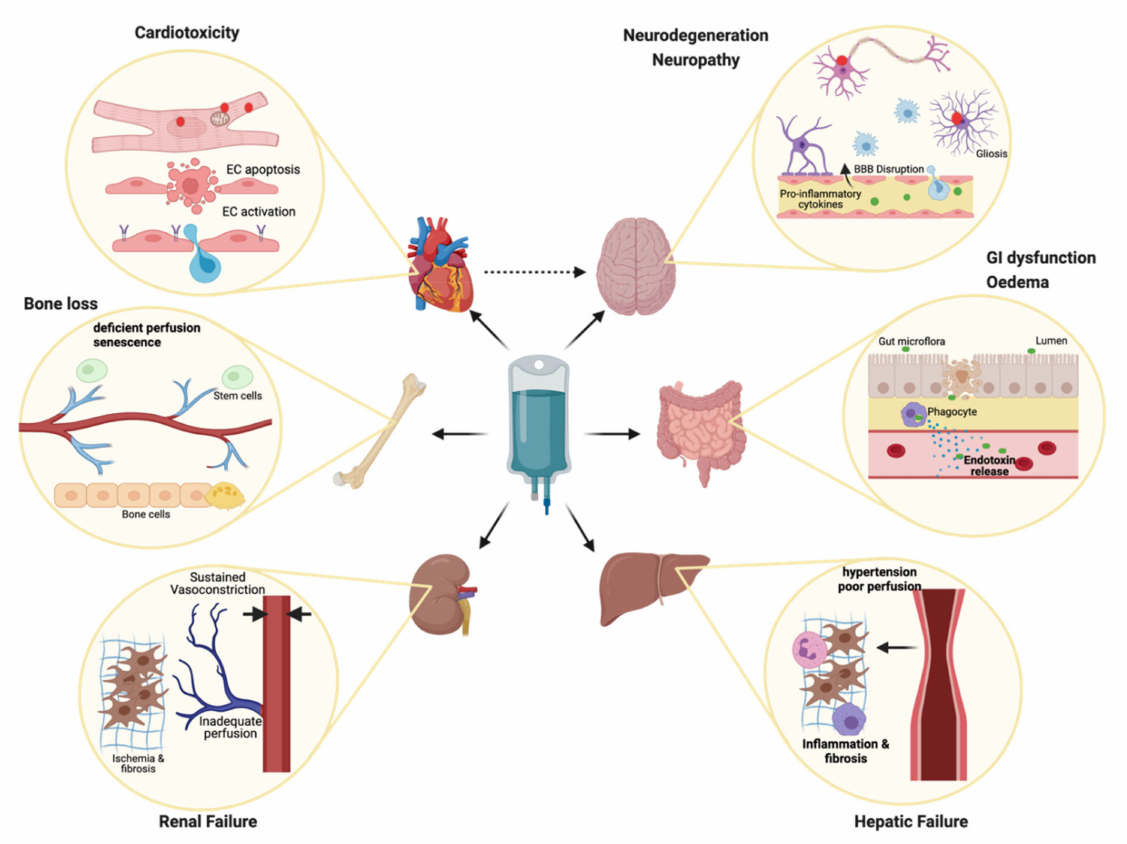
Figure 2. Tomorrow’s problem. Chemotherapy is associated with severe side effects including multi-organ failure. The best characterized side effect of therapy is cardiotoxicity, which can become apparent immediately or in the years following therapy, in severe cases leading to chronic heart failure and death. Endothelial cell apoptosis or activation can lead to increased risk of thrombotic events. Cancer patients also commonly experience chemotherapy-induced cognitive impairment, which may be the result of neurotoxicity, neuroinflammation, BBB breakdown, oxidative stress, and indirectly, cardiac insufficiency. Bone loss due to vascular defects, oestrogen deficiency or resident cell senescence, leads to an increased risk of fractures in patients. Damage to the gut lining and microbiome underlies not only typical nausea and digestive problems, but also systemic inflammation, endotoxin release and subsequent organ damage; Chronic hepatic and renal insufficiency are commonly associated with chemotherapy, and risk for these co-morbidities is compounded by multiple factors, which include loss of vasoregulation and vessel narrowing leading to ischemia, fibrosis and inflammation. After discontinuation of therapy, many of these effects persist or progress, substantially impacting survivors’ quality of life. Created with BioRender.com (accessed on 5 June 2021)